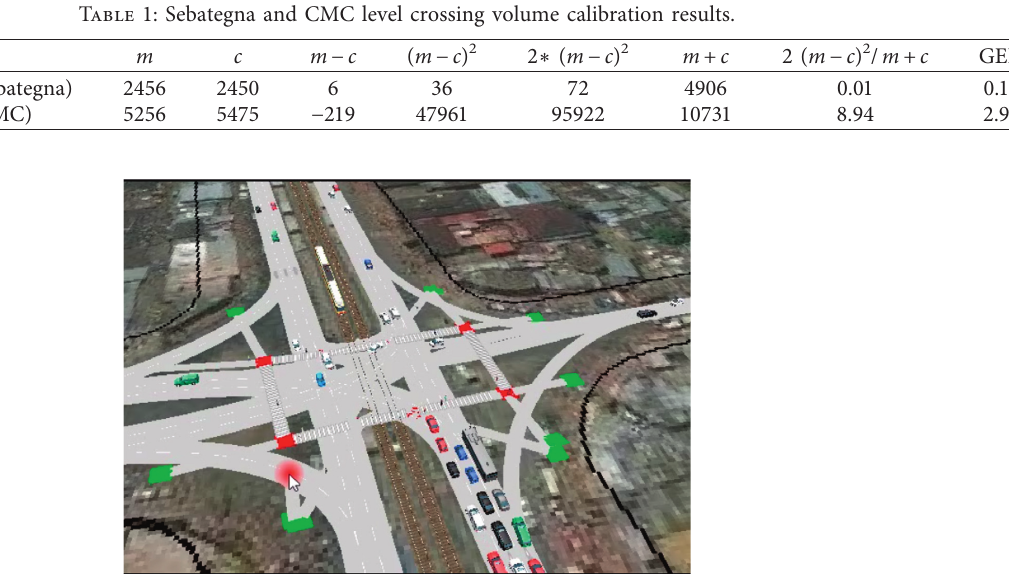
Figure 4: Snapshot display of the Sebategna level crossing during the simulation run for speed data extraction.